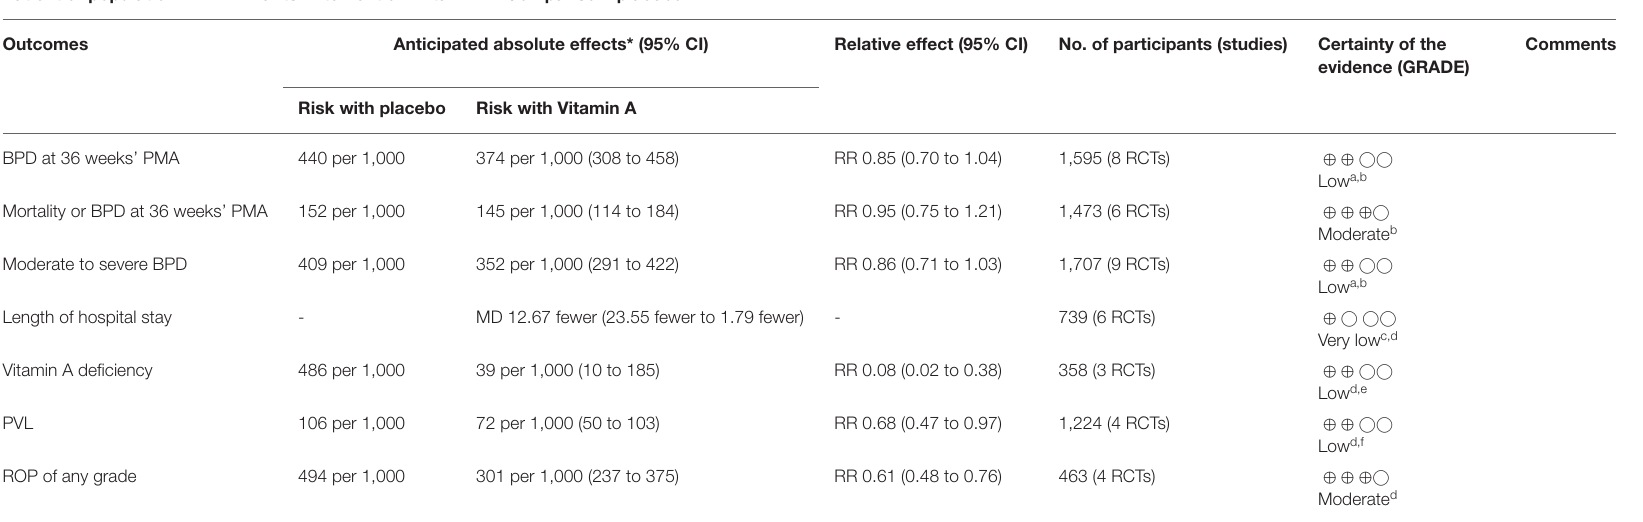
TABLE 3 | Summary of findings. Vitamin A supplementation compared with placebo for morbidity and mortality in VLBW infants Patient or population: VLBW infants. Intervention: Vitamin A. Comparison: placebo